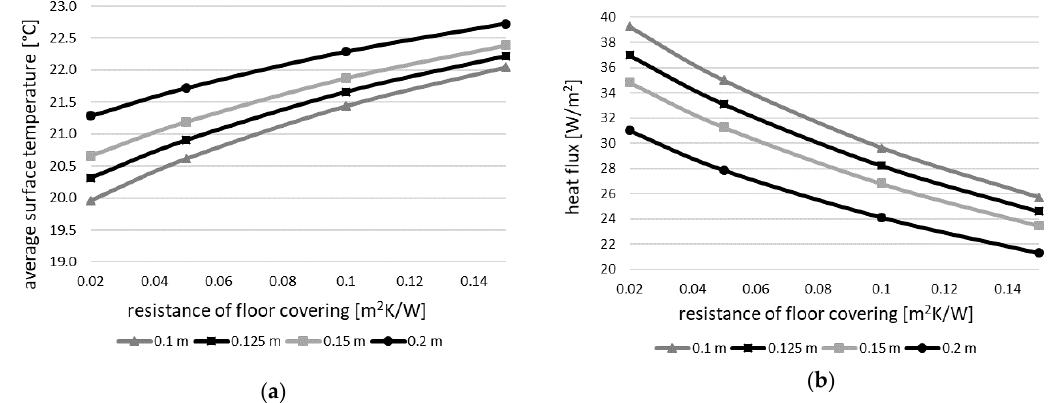
Figure 3. Relation between ( a ) average surface temperature of the cooling floor; ( b ) heat flux at the surface of the cooling floor, thermal resistance of floor covering for variable pipe spacing (water temperature 16 °C, room temperature 26